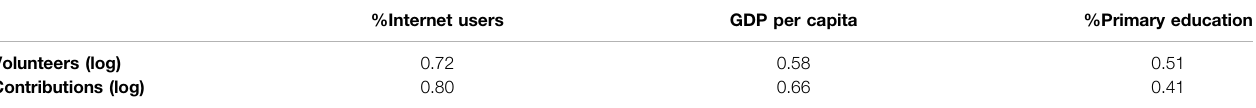
TABLE 3 | Bivariate correlations (Pearson correlation) among citizen science and socioeconomic variables among the countries under study. The highest correlation isseen betweenthenumberofInternetusersandthenumberofcontributionstotheZooniverseprojects.TheindependentvariablesarethepercentageofInternetusers,Gross Domestic Product per capita, and the percentage of adults with completed primary education. For more details see the Methods section.